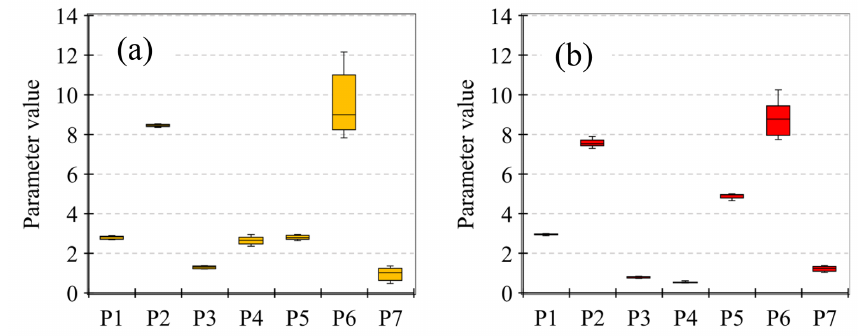
Figure 6. Adjusted WGHM parameter values for variants RS (a) and RS_Q_GW_NA (b)